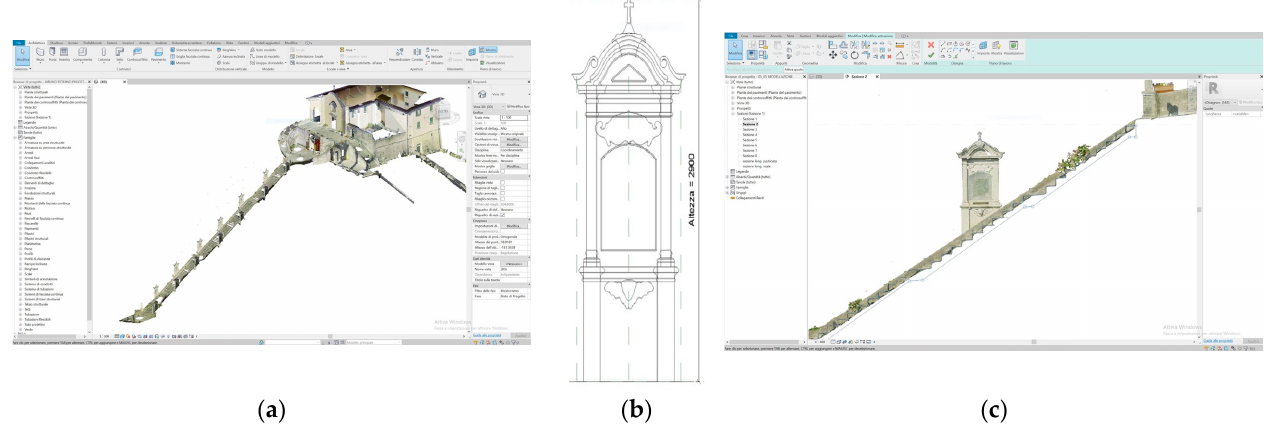
Figure 10. ( a ) Holy stairs modelling ( b ); one of the aedicules; and ( c ) holy stairs details. Once the basic structure of the aedicule object has been defined, it is possible to start modelling the various parts, such as the frame, mouldings, and decorations, using the tools in the family editor; each element is always bound to specific reference planes for the creation of parameters. Local families are used to model all the unique elements as little as possible within the project. In case of duplication, the program reads the copies as individual elements, hindering any computation operations. The vaults modelling shown in Figure 11b is a synthesis demonstrating how much the integration of several modelling types is necessary to manage and inform the shapes. Instead, the vaults within the model are extremely irregular and deserve case-by-case treatment; imported from the point cloud within Autodesk ReCap Pro, they are selected one by one, deprived of context and exported as individual projects. In the export settings, 20 mm is set between the various points to then be imported into the NURB modelling